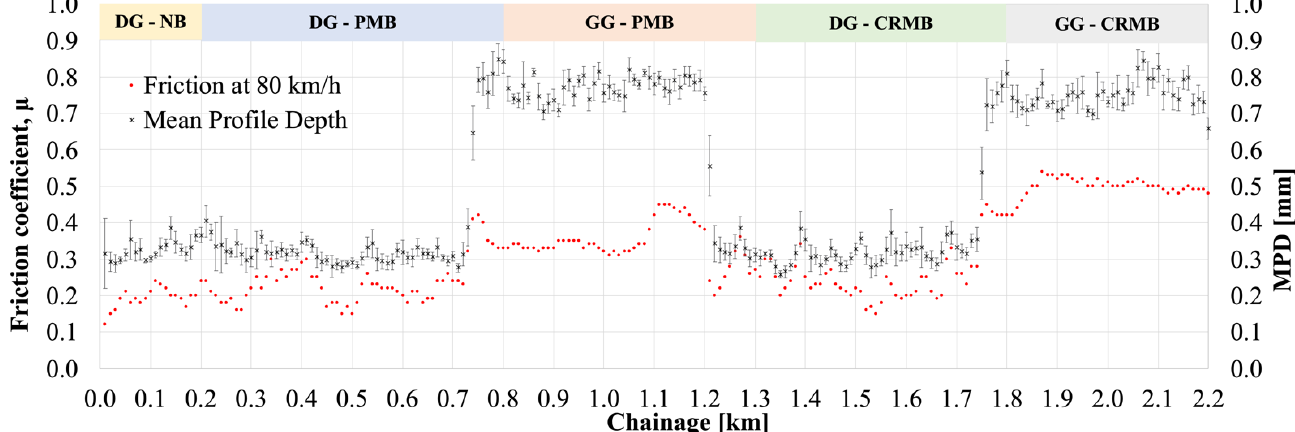
Figure 10. Mean Profile Depth and Friction Coefficients for the Various Sections.